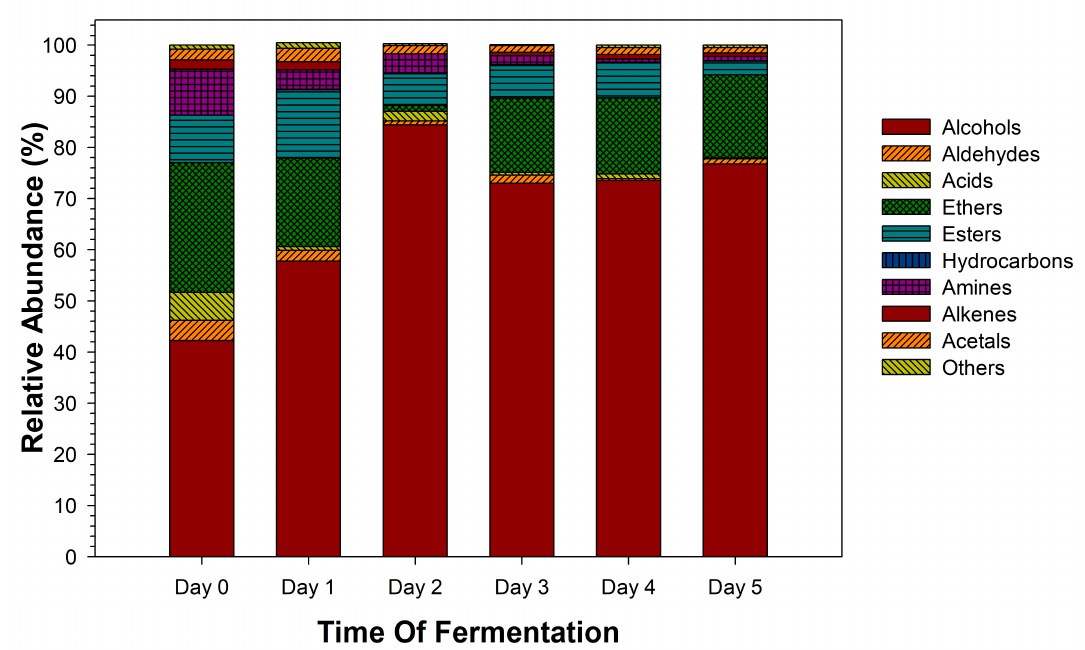
Figure 3. The relative abundance of volatile compounds among different chemical classes in fermented sotol ( Dasylirion sp.) must at different days of the process.